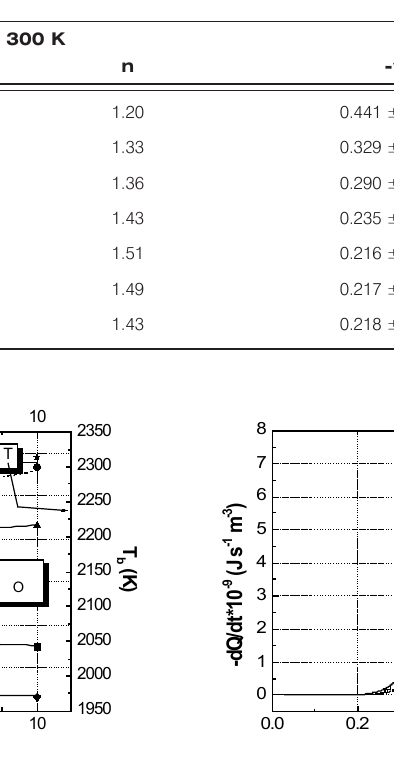
Table 2. B aric coefficients ν of burning velocity and overall reaction orders n for ethane-air .